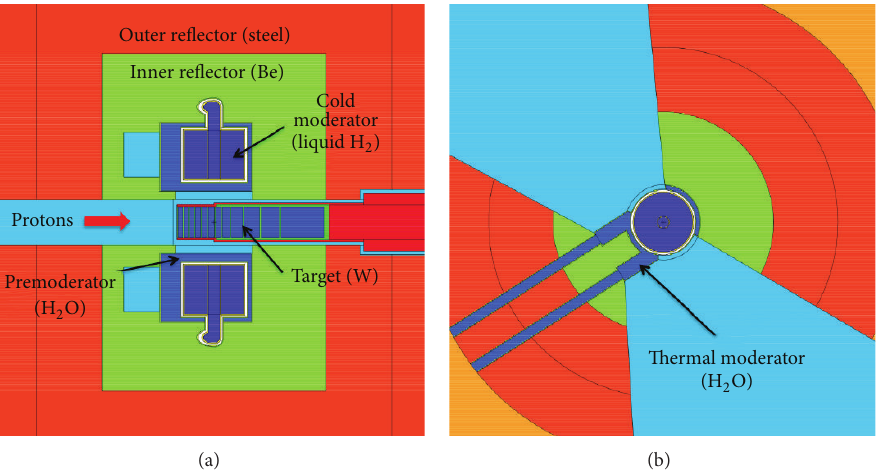
Figure 1: Vertical (a) and horizontal (b) cross-section of the target-moderator-reflector geometry in the Technical Design Report [1].